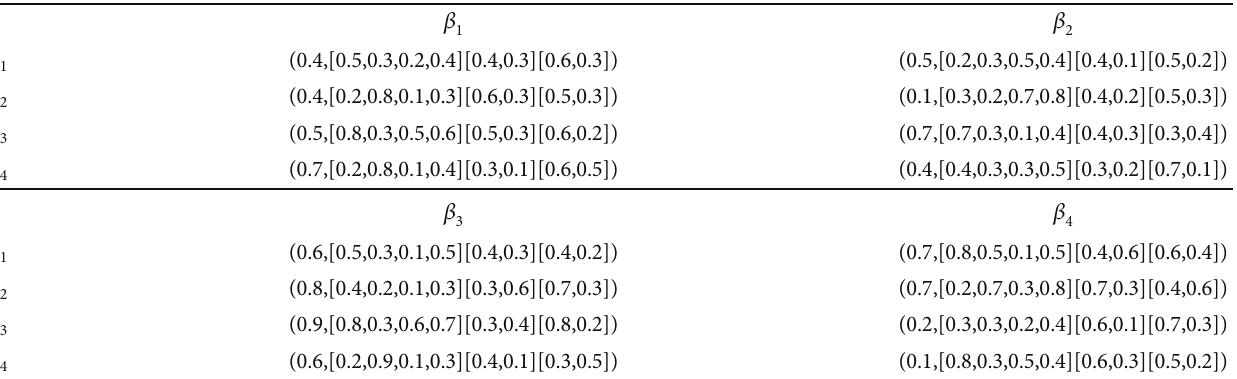
Table 4: Decision matrix of expert -4 (H 4